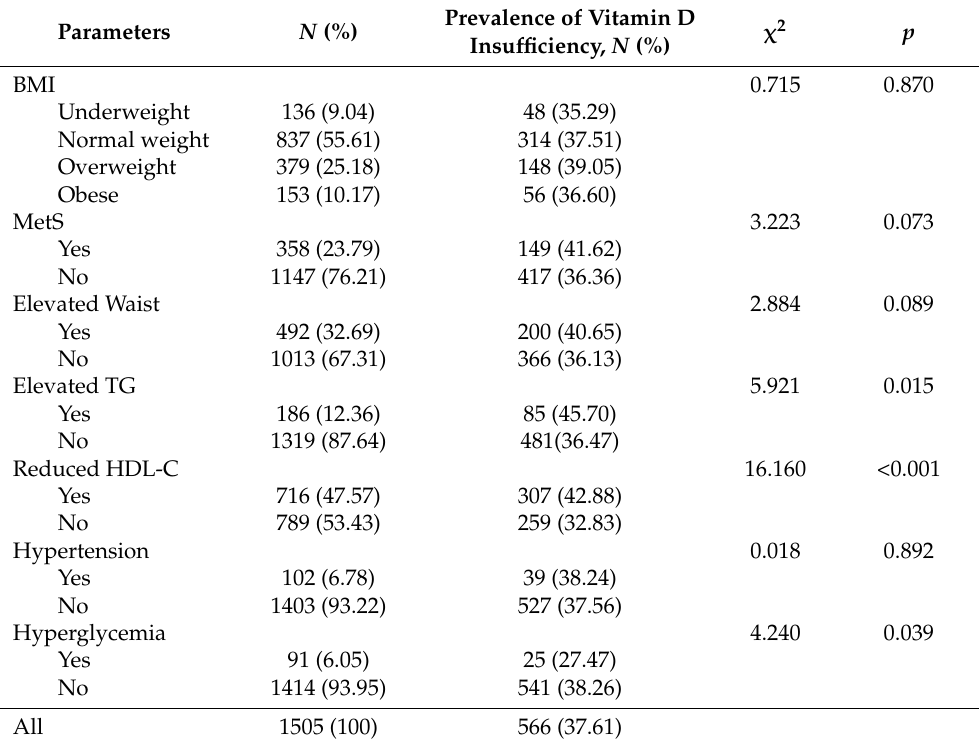
Table 5. The relationships of BMI, MetS, MetS’s components, and vitamin D